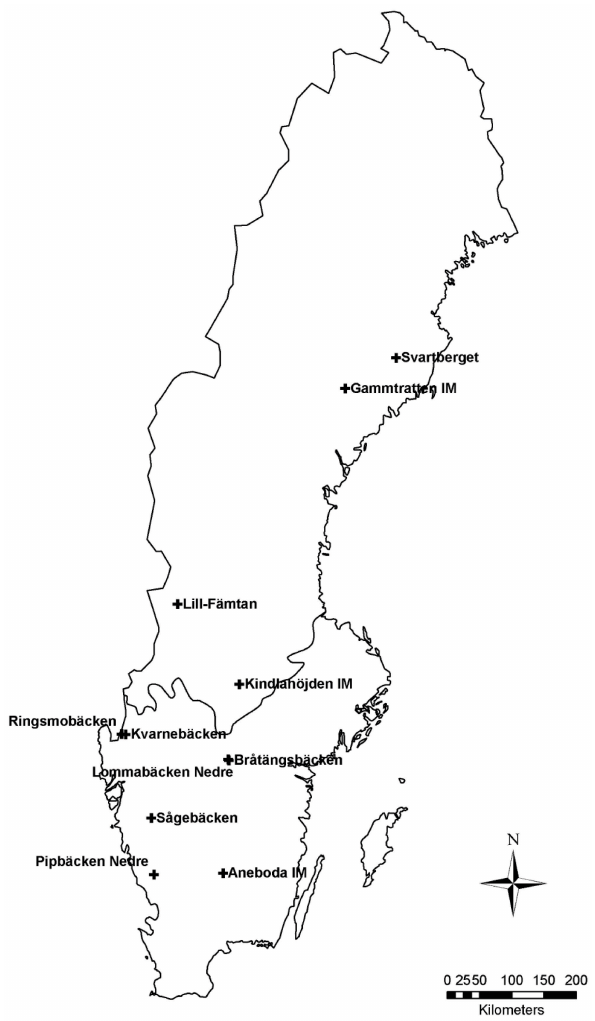
Fig. 1. Stream sites and the limes norrlandicus boundary separating Sweden into northern and southern climactic regions.